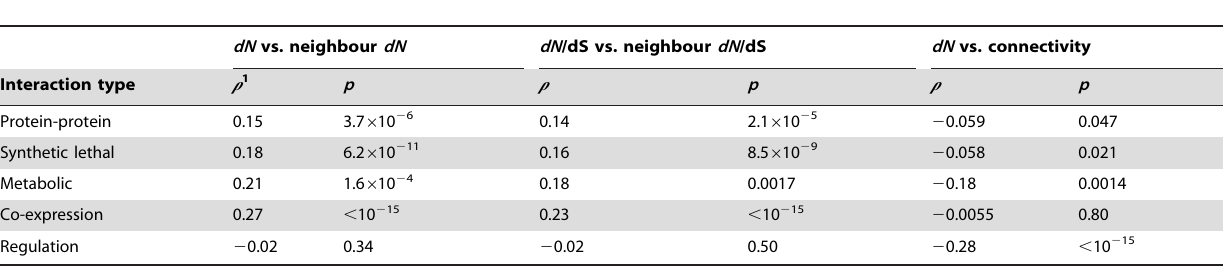
Table 1. Significant correlations between the evolutionary rates of proteins and the average rates of their network neighbours, except for the transcription regulation